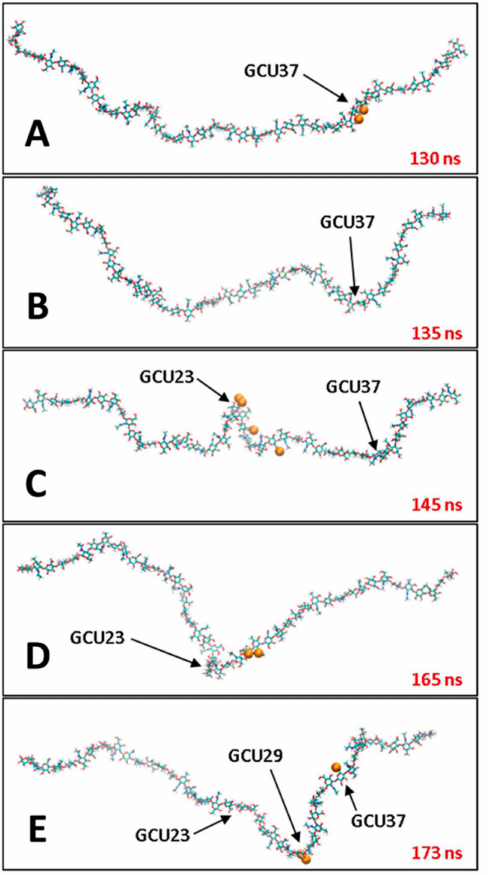
Figure 5. Hairpin-like turns induced by Na + binding to hyaluronan in atomic-resolution explicit- solvent molecular dynamics simulation. Panels ( A – E ) are successive frames from a single molecular dynamics trajectory demonstrating that Na + binding either immediately precedes or coincides with turn formation. Na + ions are drawn as orange spheres, and arrows point to the glucuronate residues where the events occur (“GCU37”, “GCU23”, “GCU29”). The elapsed simulation time, in nanoseconds, is in red font. Reprinted with permission from Ref. [126]. Copyright 2020